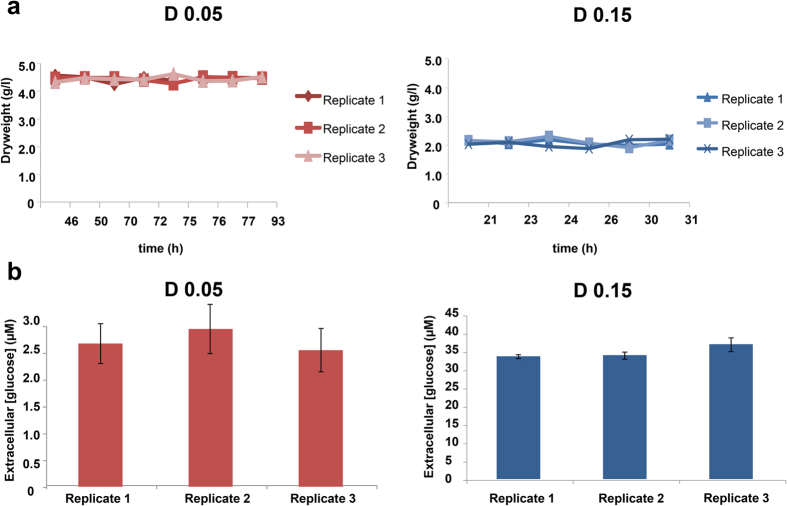
Steady-state growth of A. nidulans under low (D = 0.05) and high (0.15) glucose concentrations in chemostat cultures.(a) Fungal dryweight and (b) residual extracellular glucose concentrations were measured to confirm steady state, which was achieved after ~42 h under low glucose levels and after ~21 h in high concentrations of glucose. All experiments were performed in triplicate. Standard deviations present technical triplicates for each biological replicate.